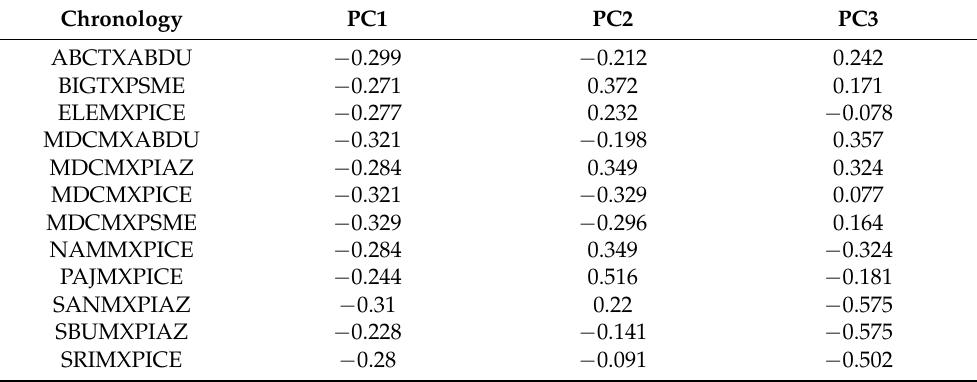
Table 3. Loadings of the 12 conifer chronologies on the first three principal components, 1931– 2000. Chronology naming conventions: first three characters = site code, TX = Texas, MX = Mexico;